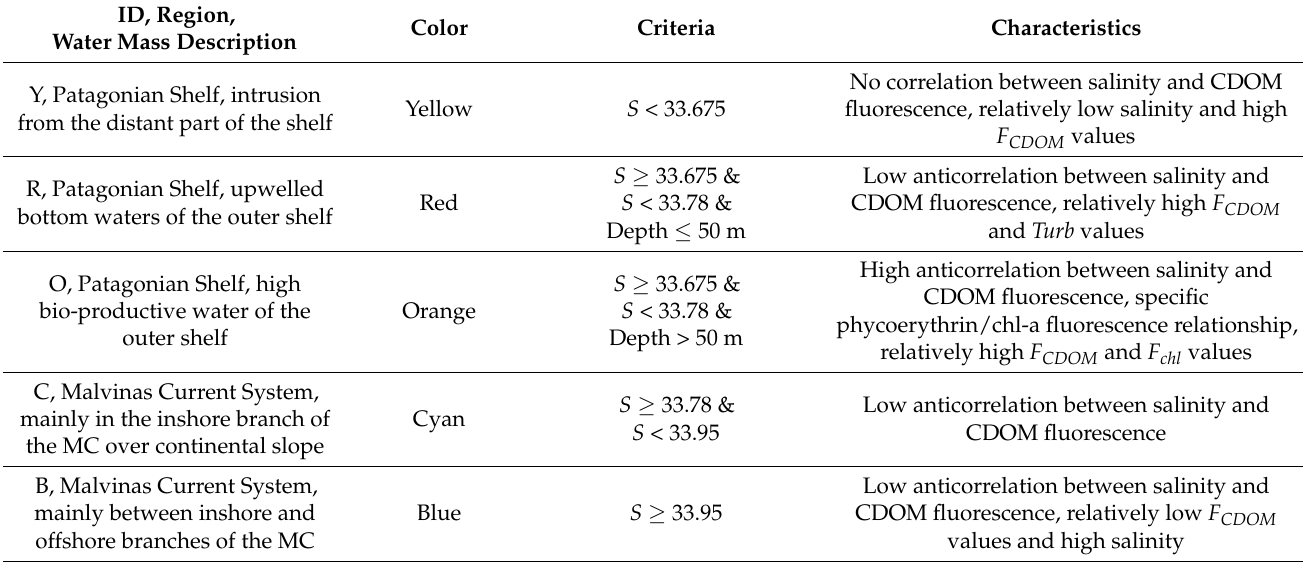
Table 2. Identified water masses along the